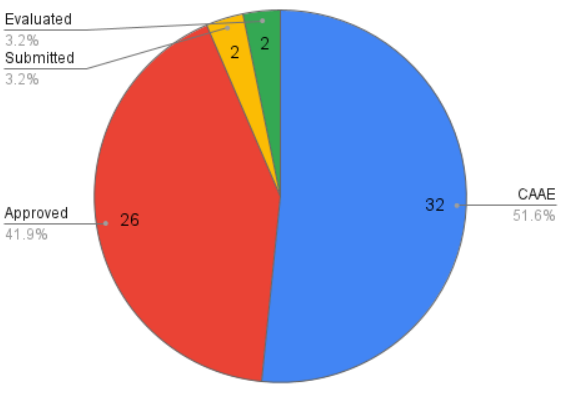
Figure 5. Ethics committee submission